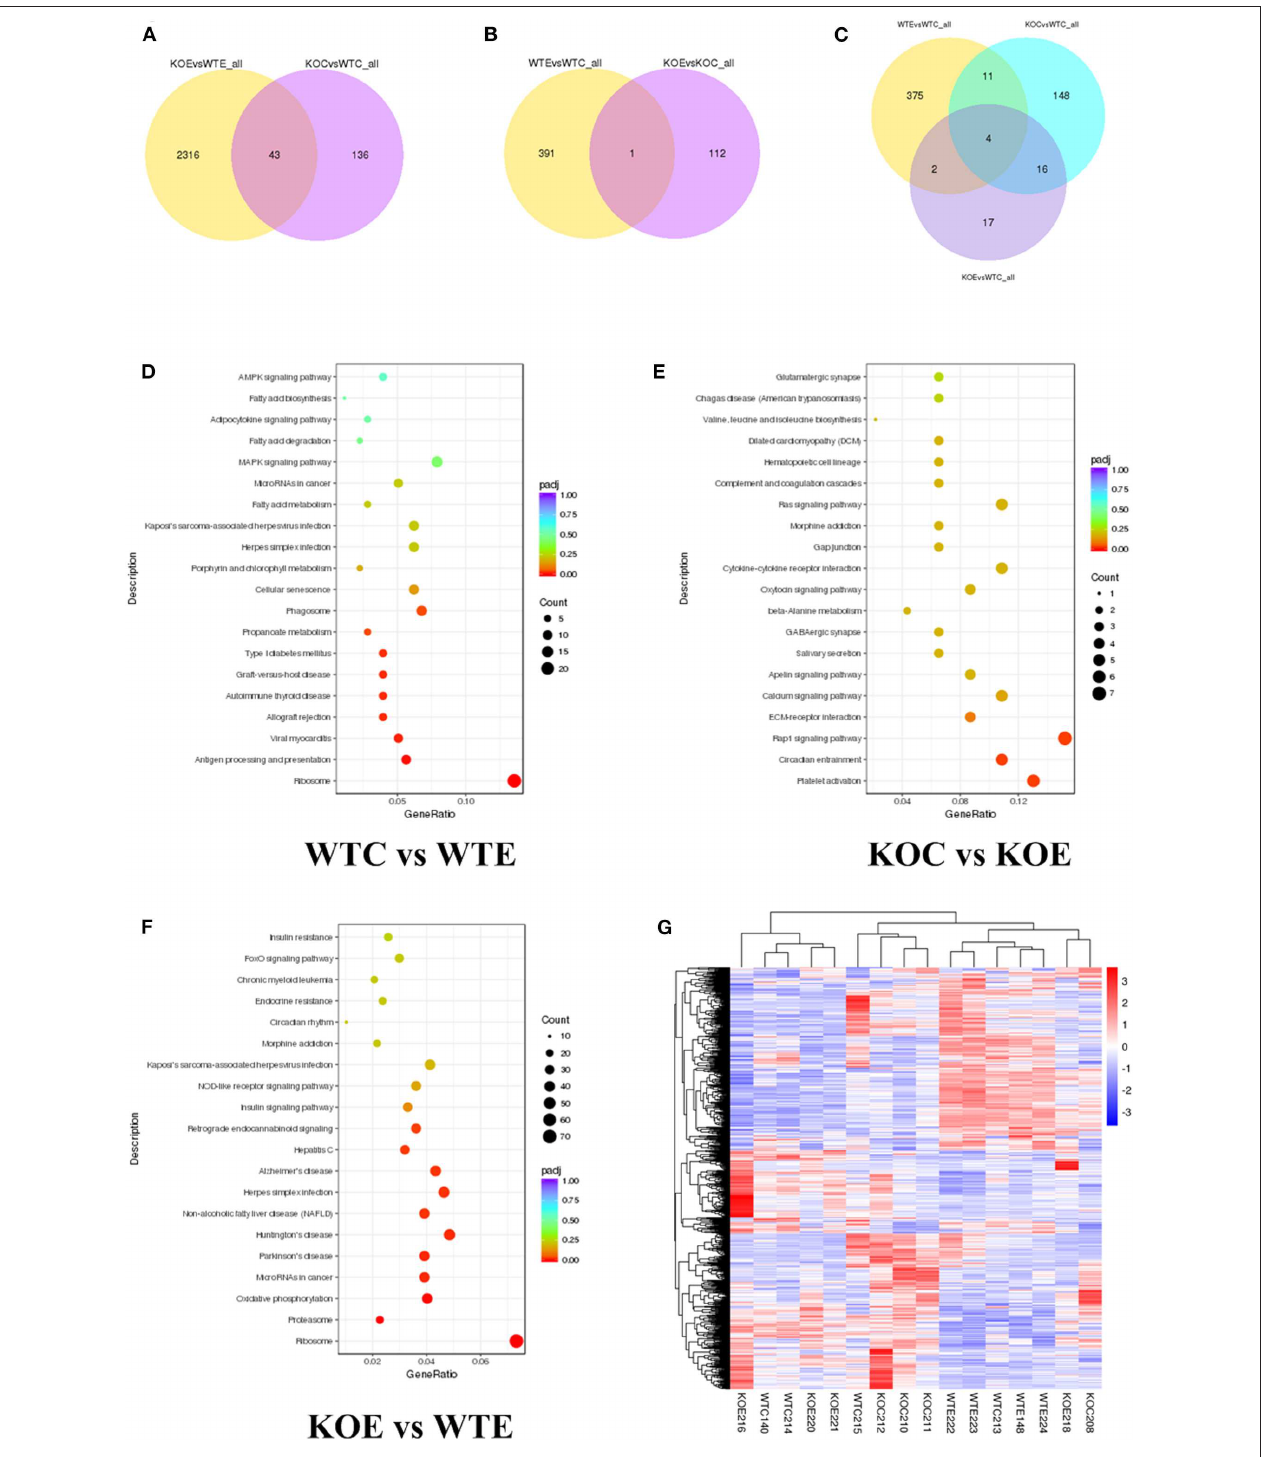
FIGURE 3 | RNA-seq results. For 6 weeks, 6–8-weeks C57/B6 mice, with or without Nrf2 knockout, were exposed to either filtered air or air containing particulate matter (PM), and the hearts were collected, snap-frozen in liquid nitrogen, and subjected to RNA-seq assay. N = 4 per group. WTC, wildtype control; WTE, wildtype exposed; KOC, knockout control; KOE, knockout exposed. (A) Venn diagram showing the number of differentially expressed genes (DEGs) shared by KOE vs. WTE and KOC vs. WTC. (B) Venn diagram showing the number of DEGs shared by WTE vs. WTC and KOE vs. KOC. (C) Venn diagram showing the number of DEGs shared by WTE vs. WTC, KOC vs. WTC, and KOE vs. WTC. (D) Pathway enrichment graph for WTC vs. WTE. (E) Pathway enrichment graph for KOC vs. KOE. (F) Pathway enrichment graph for KOE vs. WTE. (G) Heatmap for all the samples.